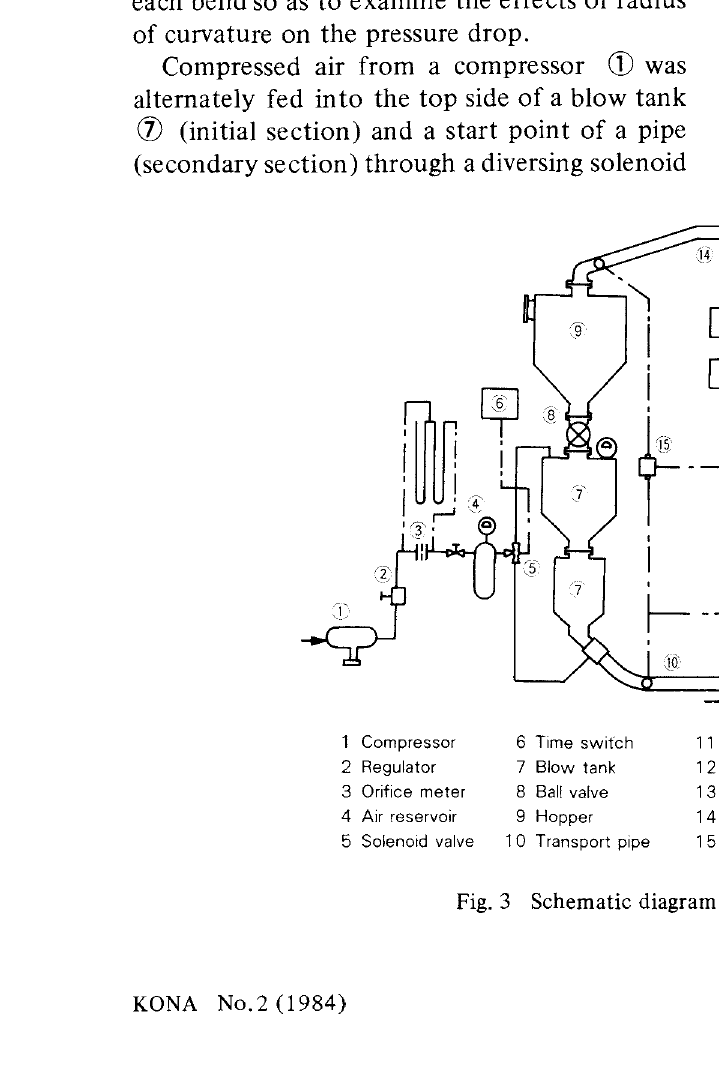
Fig. 3 Schematic diagram of experimental